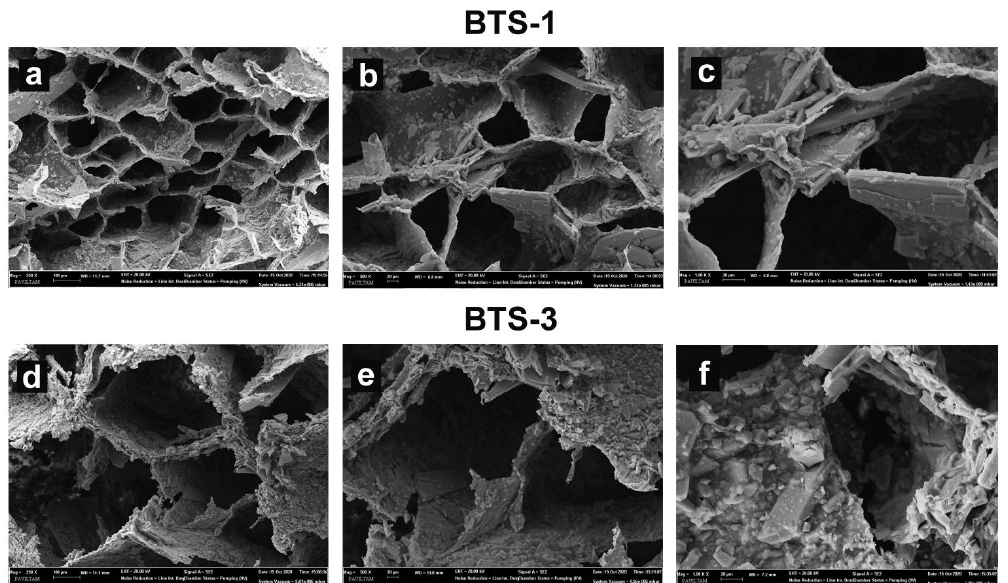
Figure 2. Morphological images of non-diatom BTS-1 scaffold (a) 250x, (b) 500x, (c) 1000x and BTS-3 scaffold (d) 250x, (e) 500x, (f)